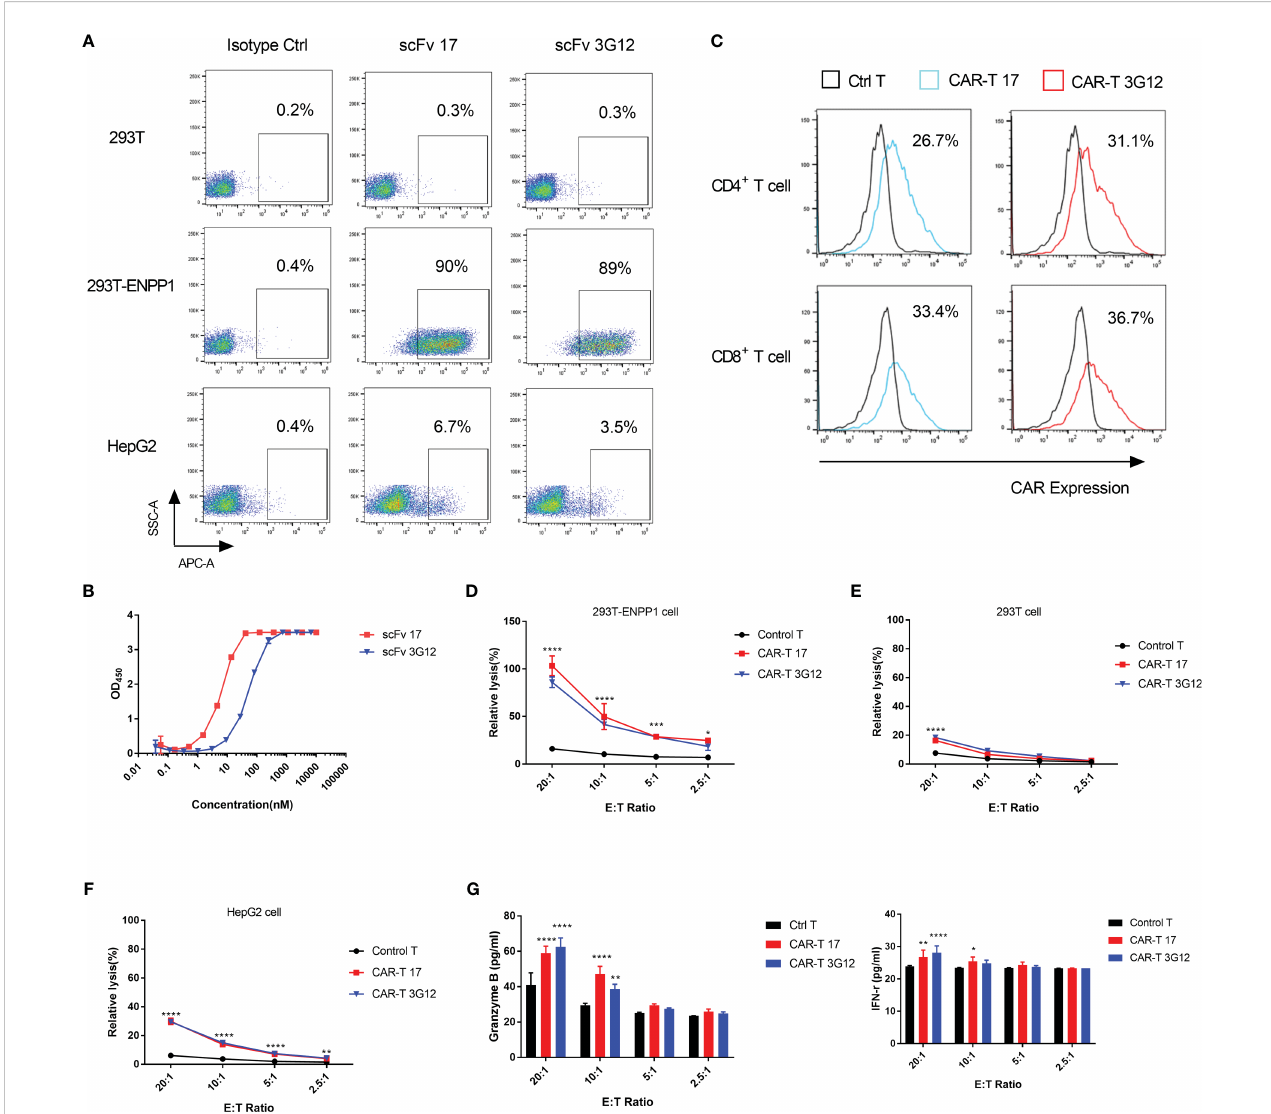
FIGURE 5 In vitro cytotoxicity of CAR T-cells to ENPP1-expressing cells (A) , Cell surface binding of scFv format antibodies 17 and 3G12 on 293T, 293T-ENPP1, and HepG2 cells. (B) , scFv 17 and 3G12 binding to recombinant human ENPP1 measured by ELISA. Experiments were performed in duplicate. (C) , CAR expression levels on CD3 + CD4 + and CD3 + CD8 + T populations of anti-ENPP1 CAR T-cells. (D – F) , Percent relative lysis of anti-ENPP1 CAR 17 and 3G12 T cells against 293T, 293T- ENPP1 and HepG2 cells, respectively. (G) , Granzyme B and IFN- g secretion in cell supernatants from control T or CAR T cells after 24h incubation with 293T- ENPP1 target cells at different ratios, as detected by ELISA. Values are reported as means ± SD. The experiment was repeated three times. Signi fi cance was tested by using two-way ANOVA, followed by Tukey ’ s multiple comparisons test. **** p <0.0001. *** p <0.001, ** p <0.01, * p